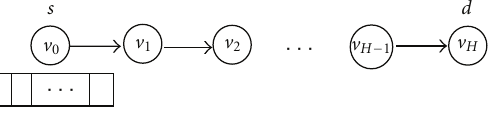
Figure 2. For a multihop path scenario, the probability